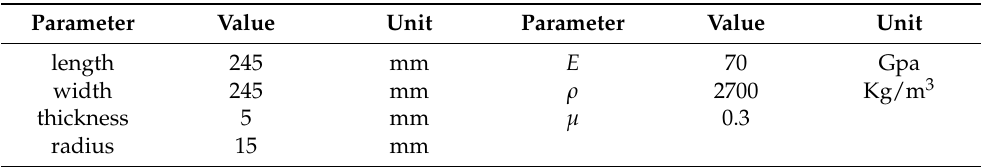
Figure 8. The FGMs plate with central circular cutout: ( a ) FFFF-F boundary condition; ( b ) CCCC-F boundary condition. Table 6. Dimensions and material parameters of the structure.